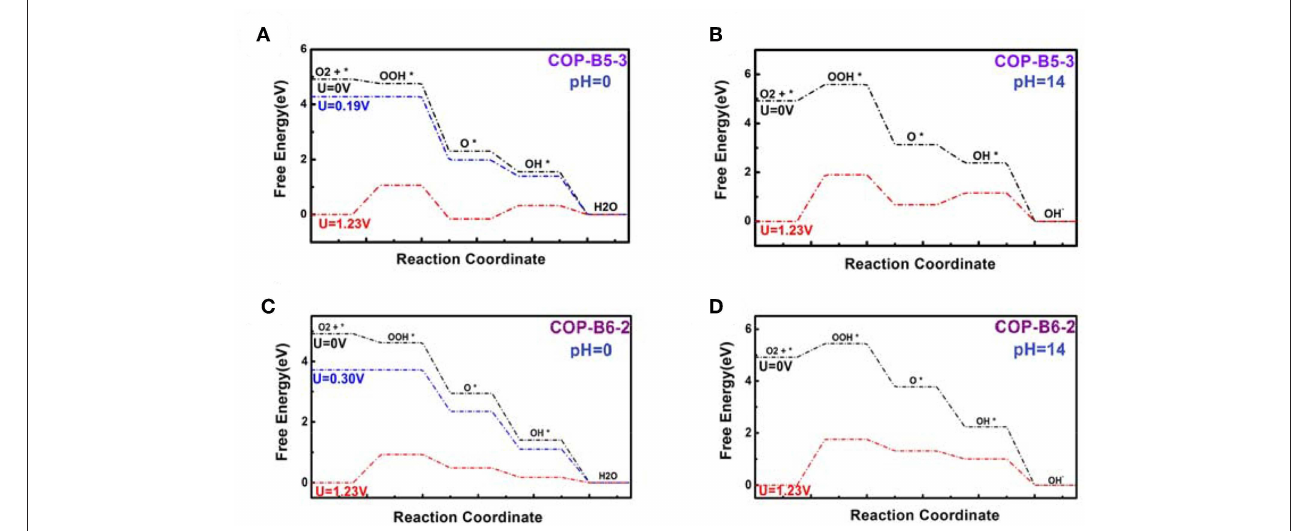
FIGURE 5 | Free energy curves of COP-B5 (Sites No. 3, A , pH = 0; B , pH = 14) and COP-B6 (Site No. 2, C , pH = 0; D , pH = 14).